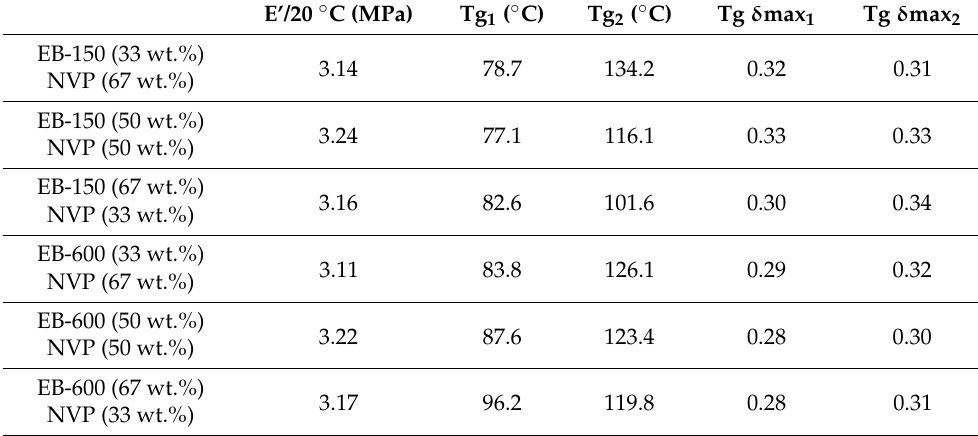
Table 6. Data of DMA measurements of